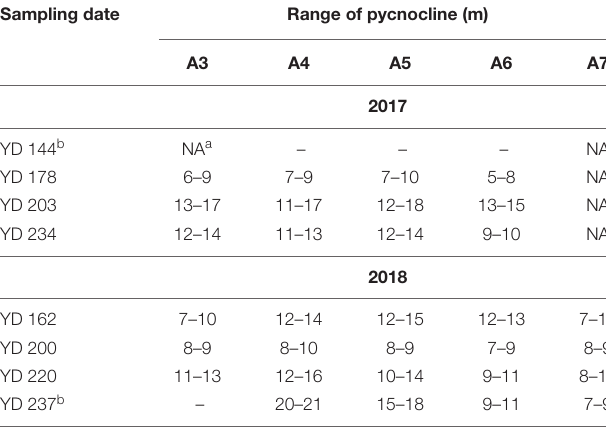
TABLE 2 | Depth range of the pycnocline based on the buoyance frequency (N 2 ).